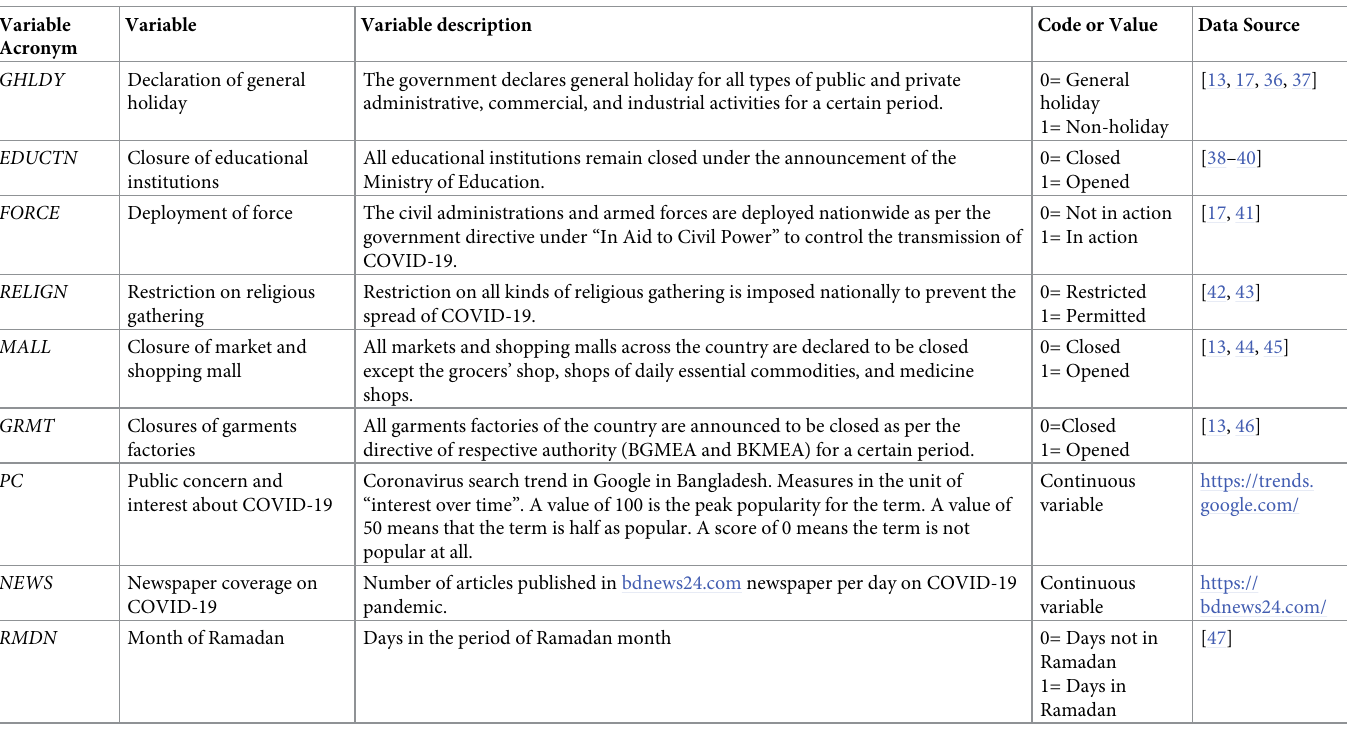
Table 1. Containment strategies (independent variables)